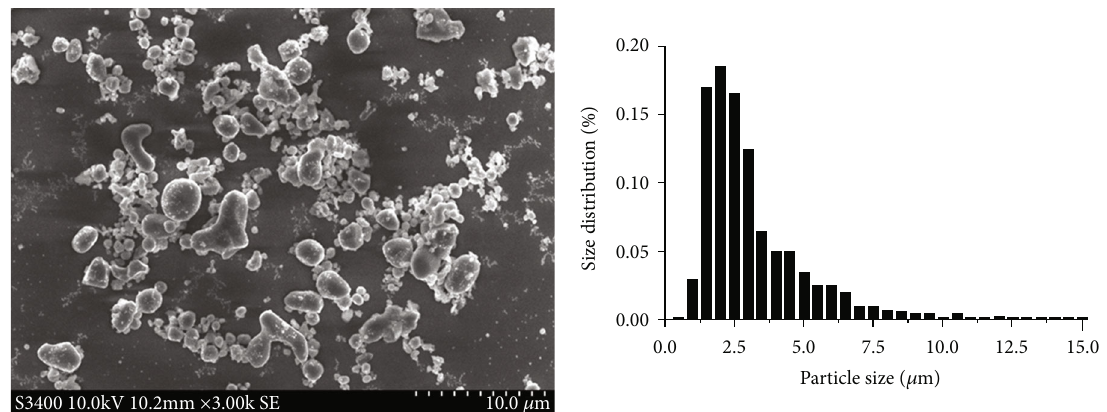
Figure 1: Scanning electron microscopy appearance of the Ti particles (magni fi cation,